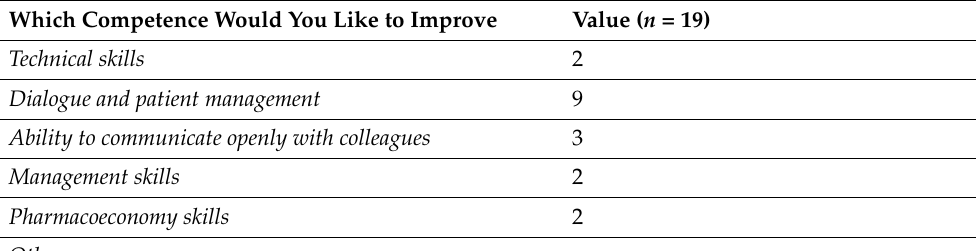
Table 3. Distribution of the responses to question four provided by the clinicians, oncologists, and radiotherapists involved in the online